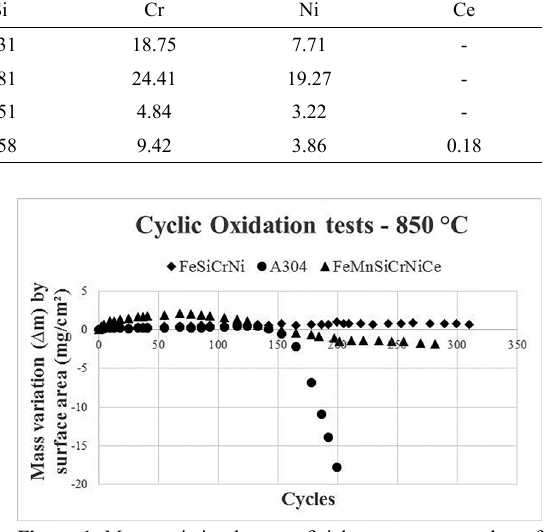
Figure 1. Mass variation by superficial area versus number of cycles in cyclic oxidation test at 850 ºC.